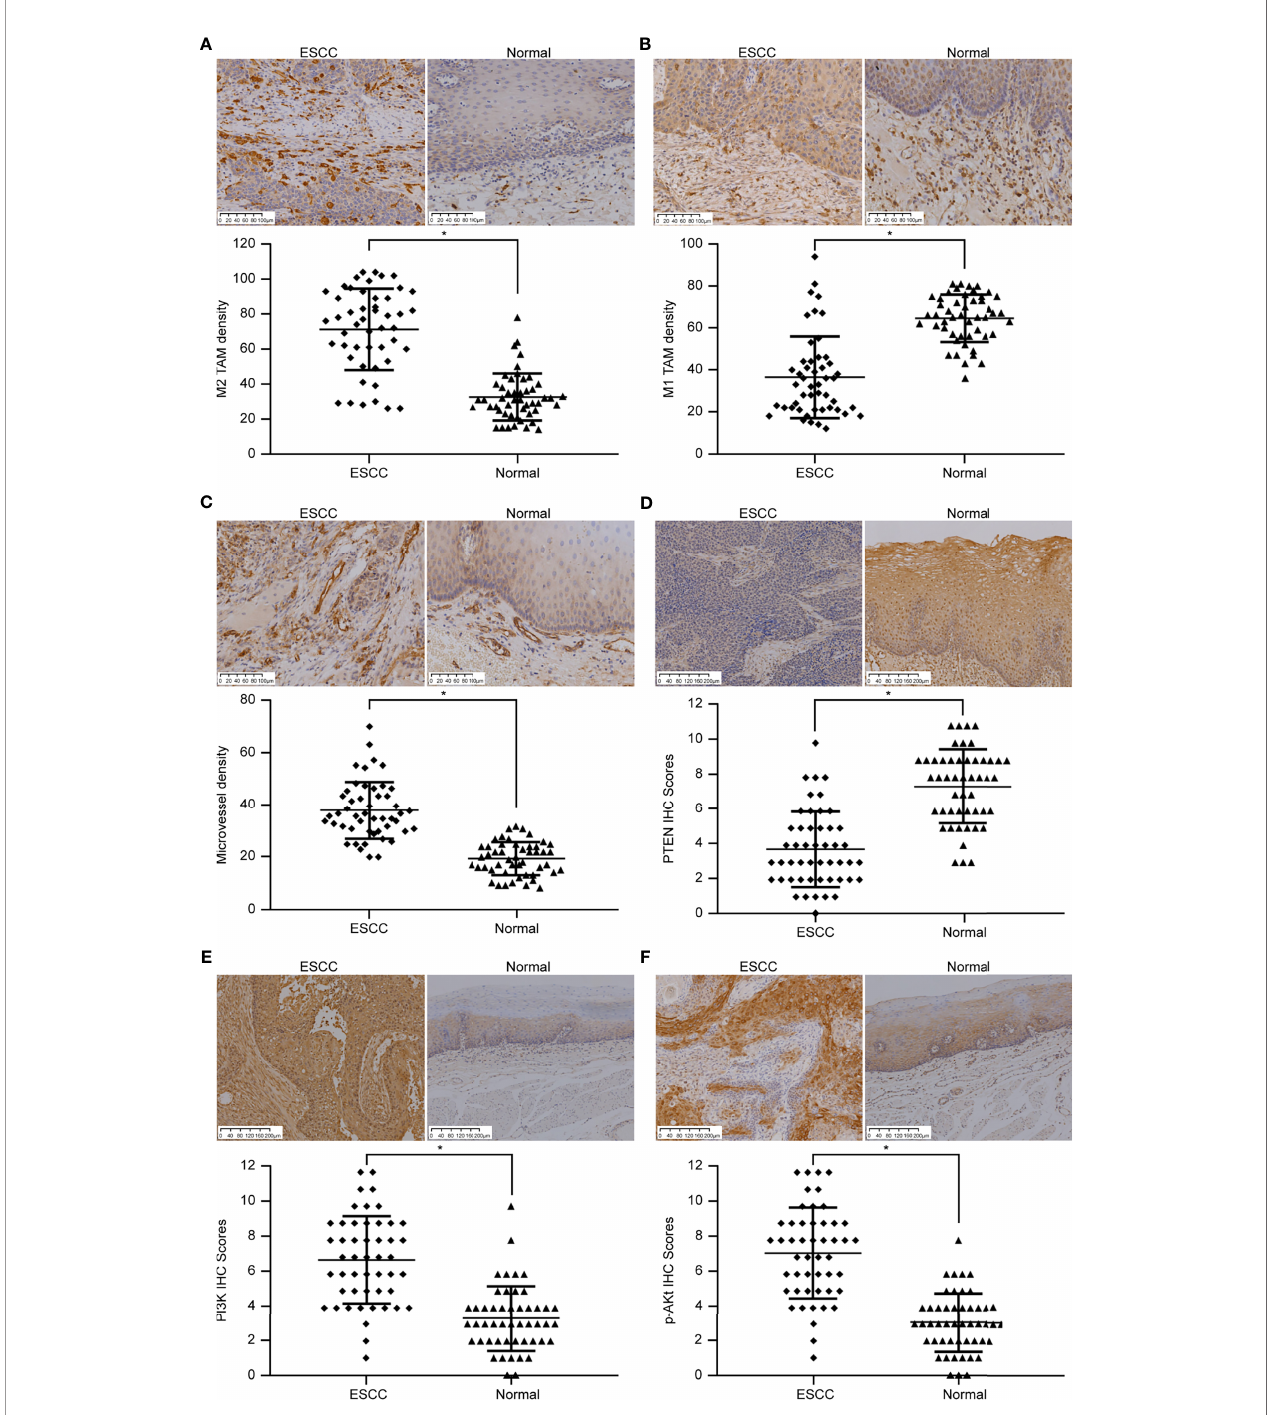
FIGURE 1 | Immunohistochemical images showing the differences in TAM in fi ltration, MVD value, and PTEN/PI3K/AKT protein expression in ESCC and adjacent normal tissues. (A) Image showing CD163-labeled M2 TAMs. The amount of M2 TAM in fi ltration in ESCC is higher than that in the normal tissues adjacent to the cancer (SP method, 200×). (B) Image showing CD16-labeled M1 TAMs. The extent of M1 TAM in fi ltration in ESCC is lesser than that in normal tissues adjacent to the cancer (SP method, 200×). (C) Image showing CD31-labeled vascular endothelial cells. The MVD value in ESCC is higher than that in normal tissues adjacent to the cancer (SP method, 200×). (D) Image showing PTEN staining. PTEN expression score in ESCC is lower than that in normal tissues adjacent to the cancer (SP method, 100×). (E) Image showing PI3K staining. PI3K expression score in ESCC is higher than that in normal tissues adjacent to the cancer (SP method, 100×). (F) Image showing p-AKT staining. p-AKT expression score in ESCC is higher than that in normal tissues adjacent to the cancer (SP method, 100×). * p <